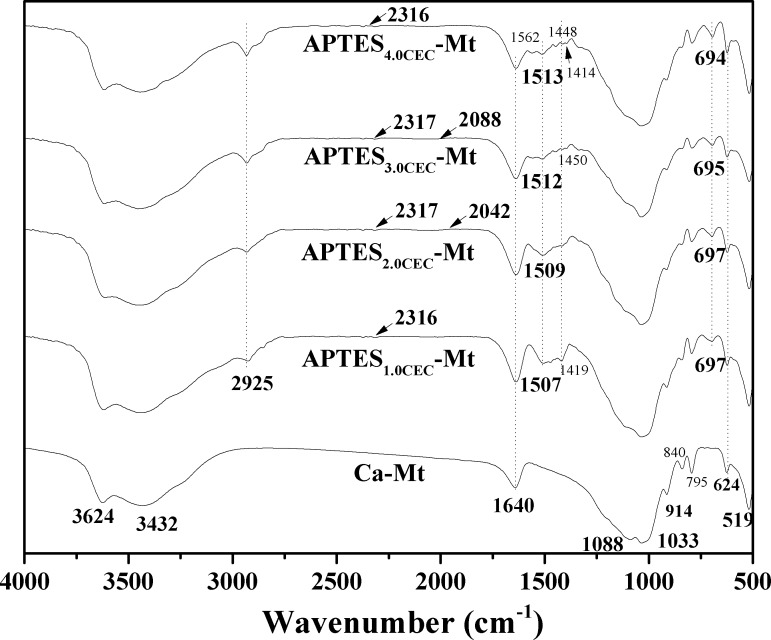
FTIR of Ca-Mt, APTES1.0CEC-Mt, APTES2.0CEC-Mt, APTES3.0CEC- Mt and APTES4.0CEC-Mt.